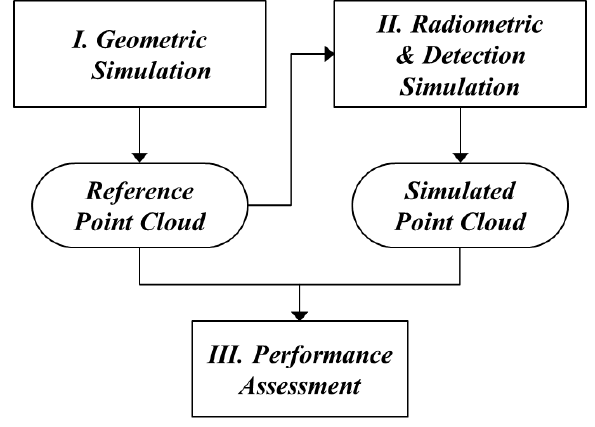
Figure 21. Overview of performance assessment.